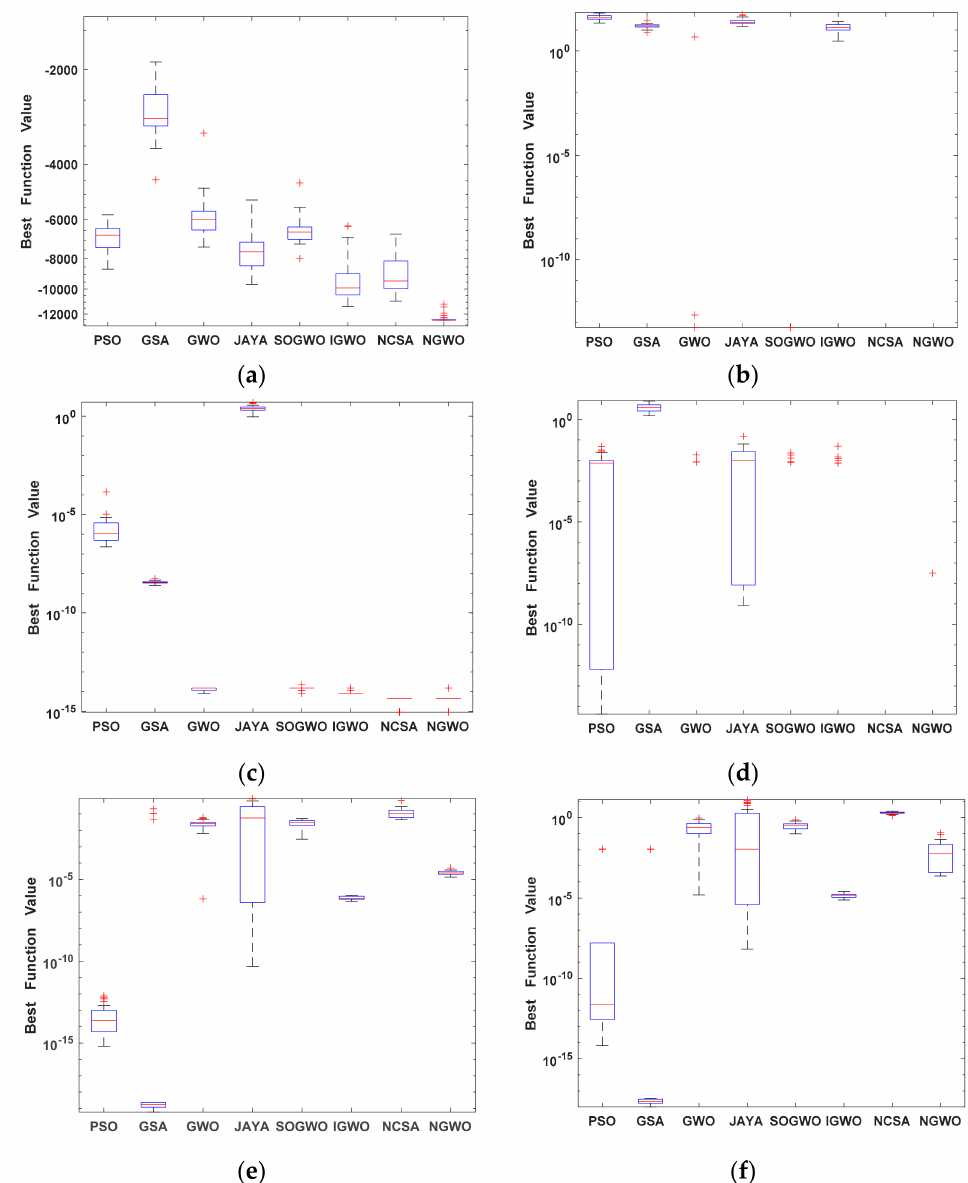
Figure 6. Box plot of the multi-modal benchmark functions (F 8 –F 13 ). Here, ( a ) represents F 8 , ( b ) represents F 9 , ( c ) represents F 10 , ( d ) represents F 11 , ( e ) represents F 12 , ( f ) represents F 13 .